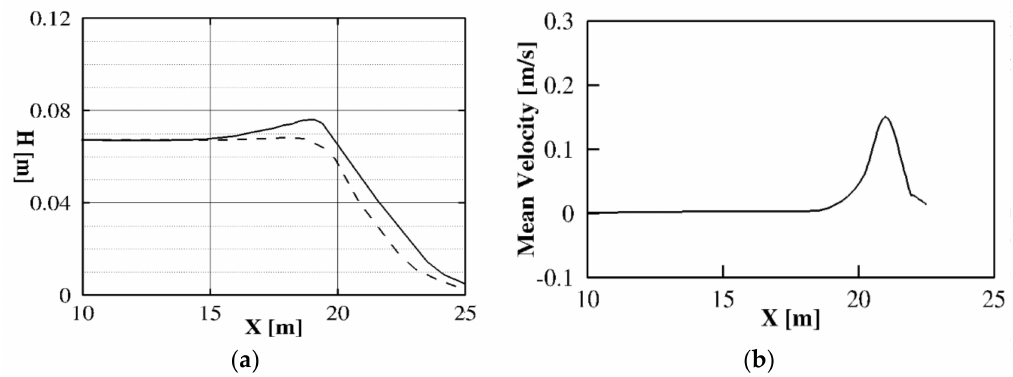
Figure 8. Case 1: ( a ) Wave height comparison between section C-C’ (solid line) and section D-D’ (dashed line); ( b ) Time-averaged (over 120 wave periods) cross-shore velocity component along the section in the gap between the barriers (section